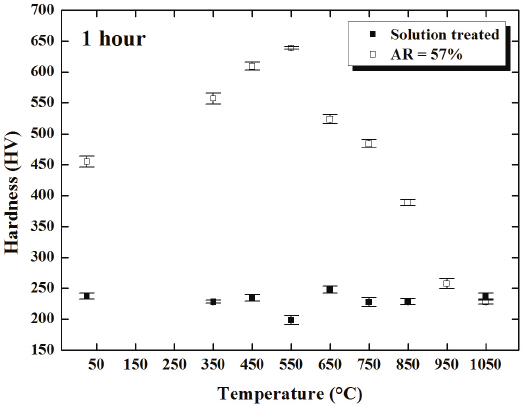
Figure 4. Effect of the annealed on the hardness for different conditions: solution treated and deformed with 57% of area